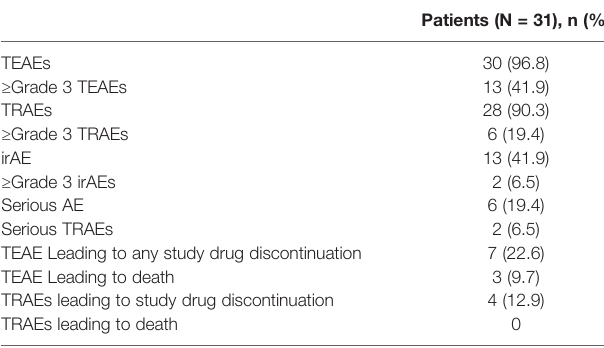
TABLE 3 | Overview of adverse events